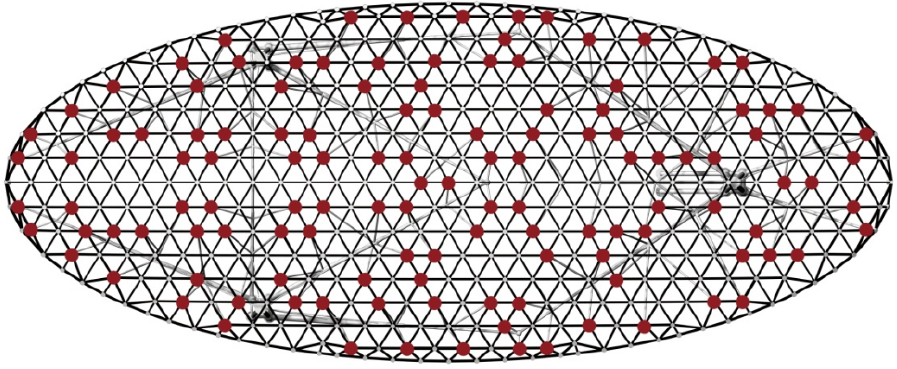
Figure 4. Roof plan.